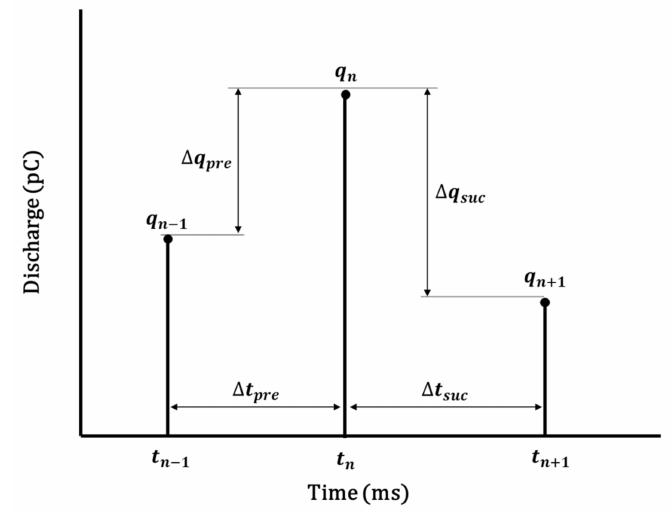
Figure 6. Basic parameters of pulse sequence analysis (PSA).